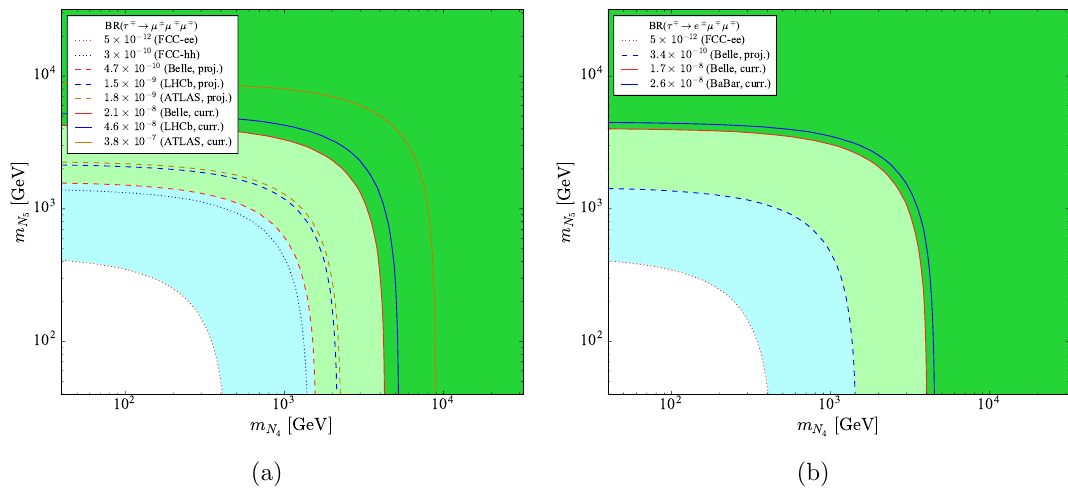
Figure 6. Current and future branching ratio limits in the parameter plane of the right-handed neutrino masses m N and m N for the LRSM. (a) Shows the limits from the decay (cid:28) (cid:7) ! (cid:22) (cid:6) (cid:22) (cid:7) (cid:22) (cid:7) , 4 5 and (b) shows the limits from the decay (cid:28) (cid:7) ! e (cid:6) (cid:22) (cid:7) (cid:22) (cid:7) . the equivalent plots for BP2. For BP1, the current limit from Belle imposes the constraint on the right-handed neutrino masses m N (cid:20) 290 GeV for the doubly charged Higgs mass M = 420 GeV for the (cid:28) (cid:7) ! (cid:22) (cid:6) (cid:22) (cid:7) (cid:22) (cid:7) and (cid:28) (cid:7) ! e (cid:6) (cid:22) (cid:7) (cid:22) (cid:7) decays. This M (cid:14) (cid:6)(cid:6) R